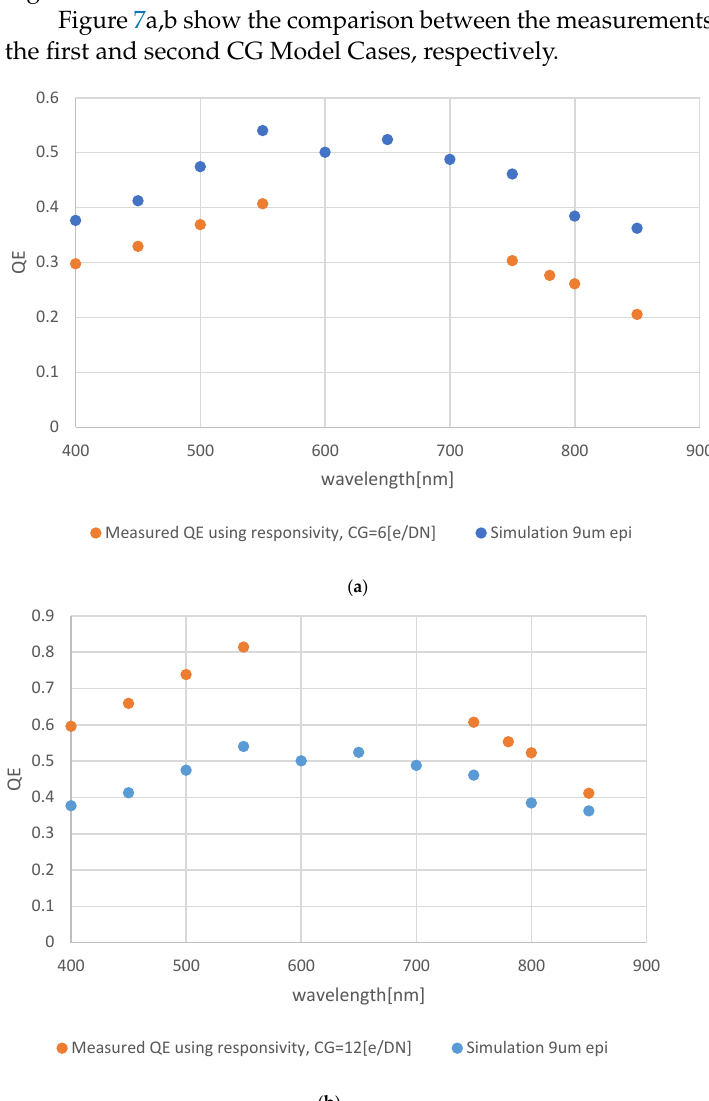
Figure 7. ( a ) Measured and Simulated QE using Model Case I of Section 3 for CG modeling, with the value of CG = 6 [e/DN]. ( b ). Measured and Simulated QE using Model Case II (Section 3), with the value of CG = 12 [e/DN].